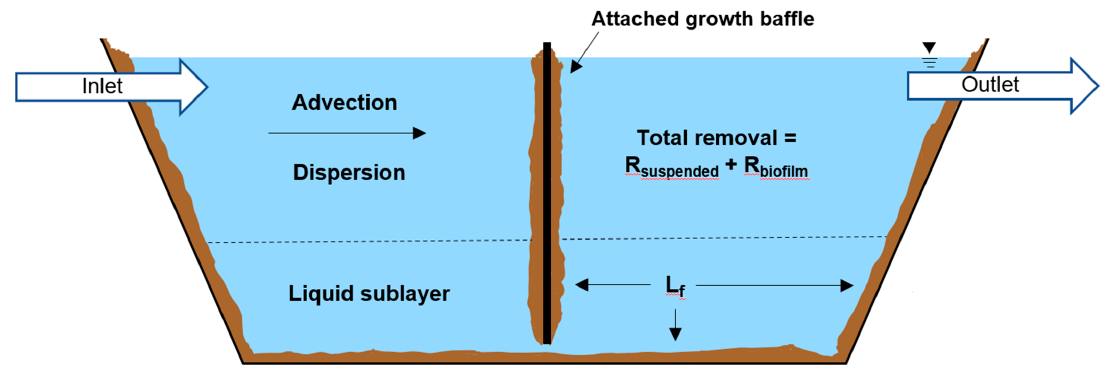
Figure 1. A conceptual illustration of a biofilm model in a facultative pond. This model involves substrate mass balances in bulk liquid flow and biofilm. Waste transportation is governed by diffusion and dispersion [21,22]. R suspended and R biofilm represent the biological oxygen demand (BOD) removal efficiency when considering suspended or biofilm biomass only, respectively. L f refers to the biofilm attached on baffles and pond floor and walls. In this study, the total removal is considered as the sum of R suspended and R biofilm